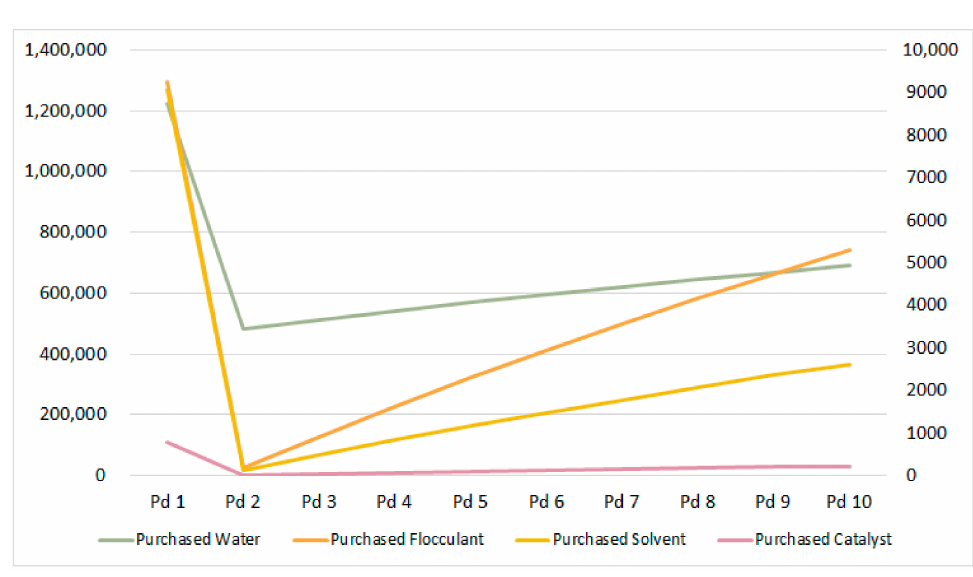
Figure 5. Behavior of purchase amounts for each input material over